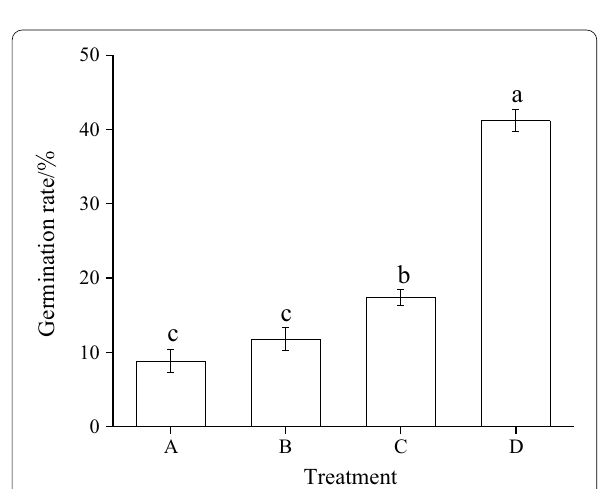
Fig. 4 Effect of EBS03 on microsclerotia germination of V. dahliae . A original filtrate of EBS03; B 1/2 dilution; C : 1/4 dilution; D